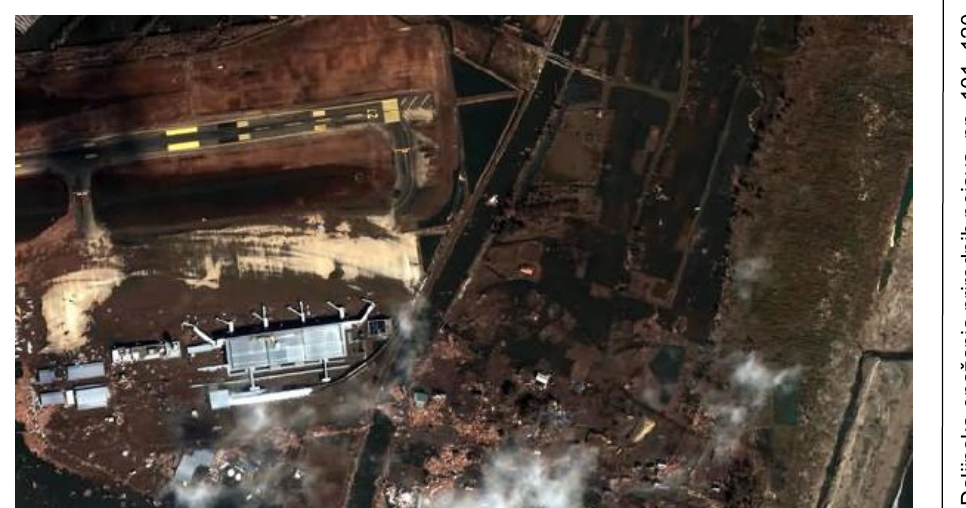
Figure 13 – The Sendai airport after the